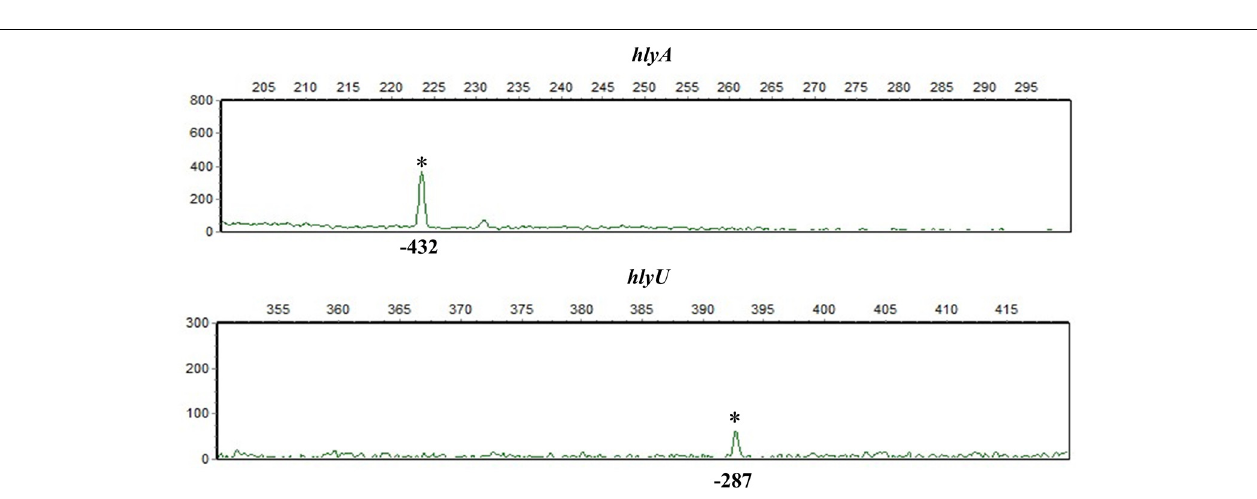
FIGURE 5 | Negatively regulation of hlyU and hlyA by Fur. The luminescence assay (A) was done as Figure 2 . The qRT-PCR (B) and DNase I footprinting assay (C) were done as Figure 3 . Lanes-I, II, and III contain 0, 2.95, and 8.85 pmol His-Fur, respectively.